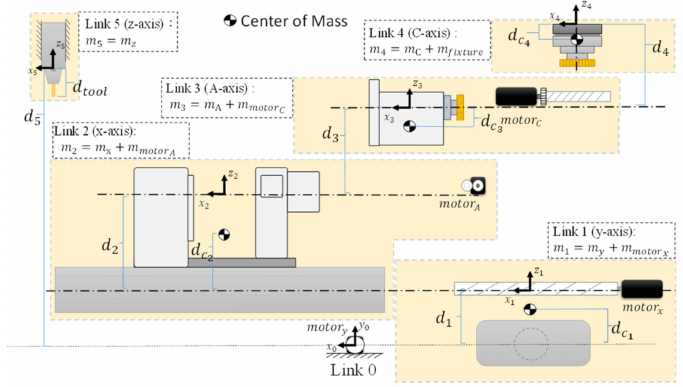
Figure 1. Exploded view of the five-axis machine (Model: NXV560A).